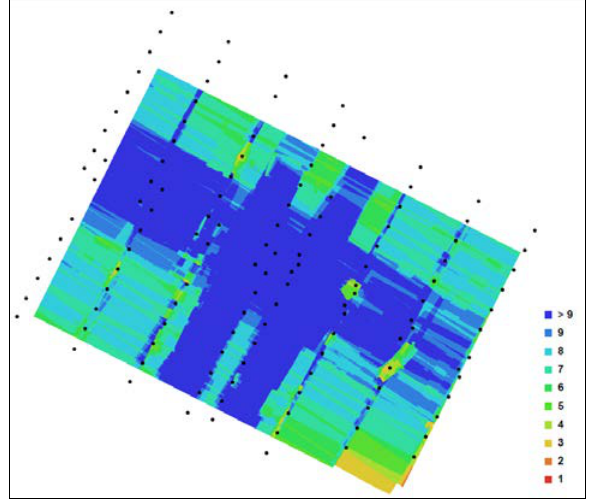
Figure 3 - Image overlap and camera locations of 140 m